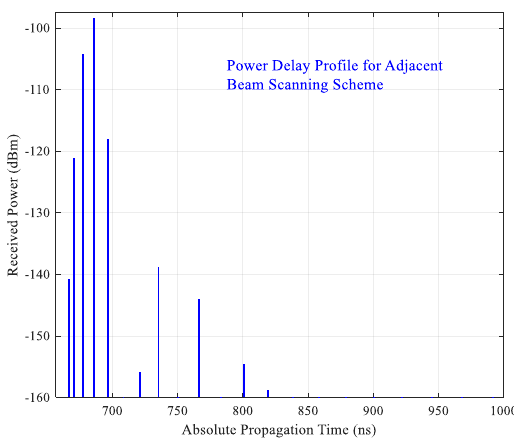
Figure 5. Power delay profile for conventional schemes (adjacent beam and aggregation).